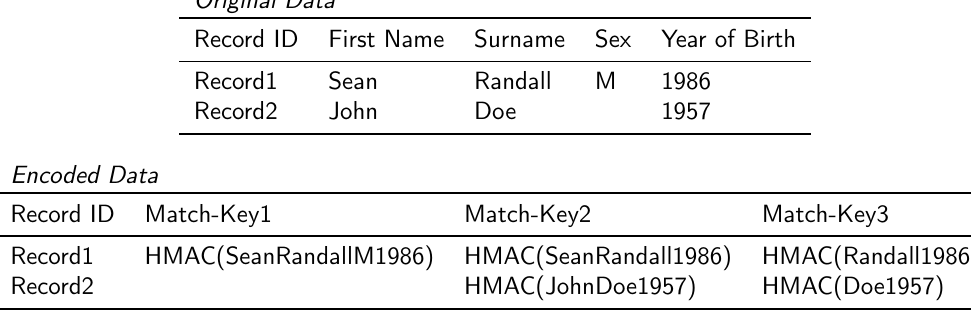
Table 2: An example of the encoding process: two un-encoded records (top) are encoded (bottom) using the field state combinations from Table